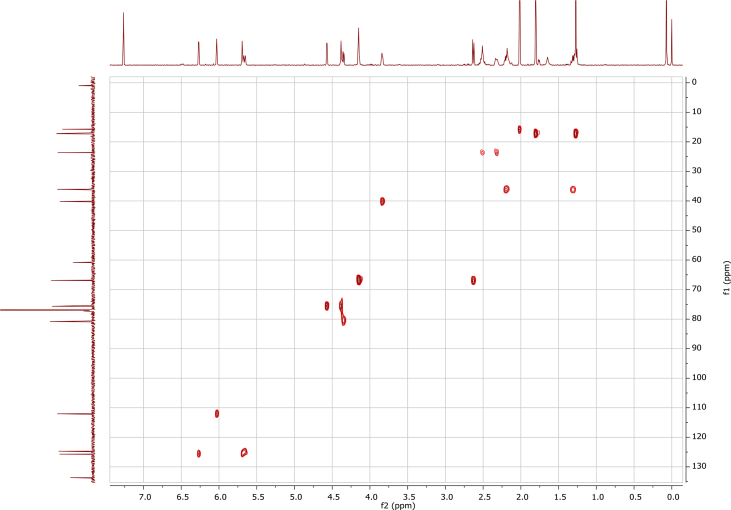
HSQC (CDCl3) spectrum of compound 5.